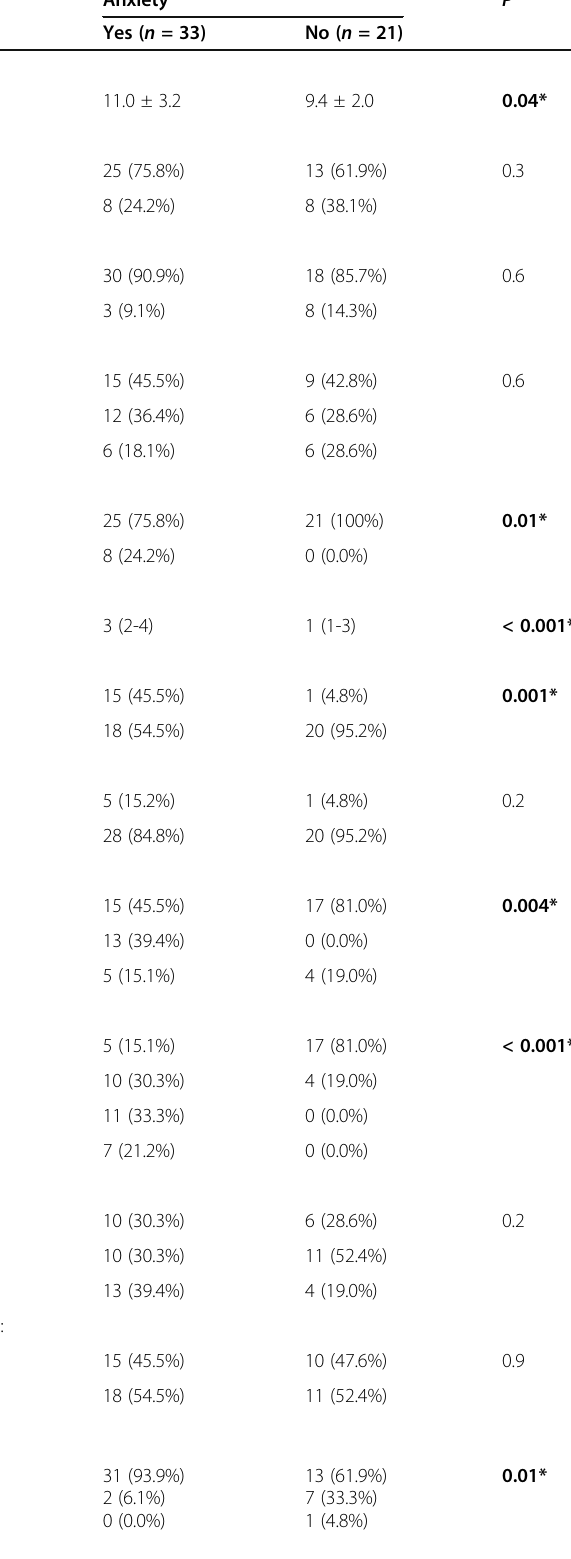
Table 4 Association between anxiety and other characteristics in mothers of ADHD children